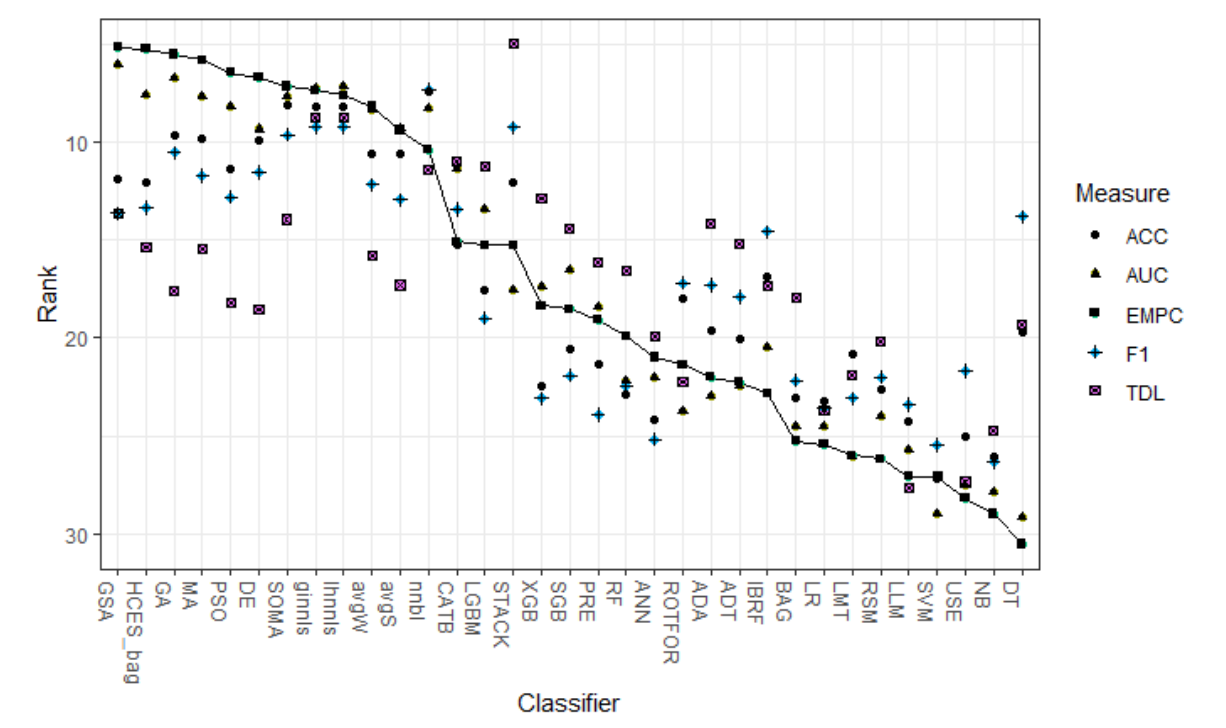
Figure 2. The average rank across 11 data sets for each classifier for each performance measure.